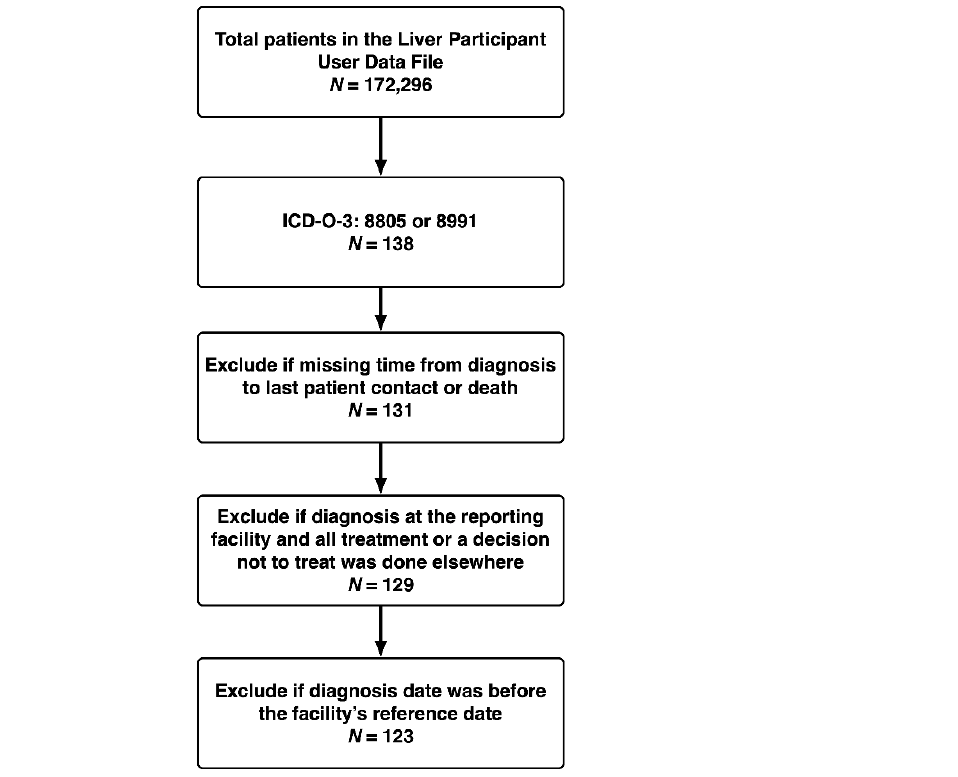
Figure 1. Assembly of Analysis Cohort.